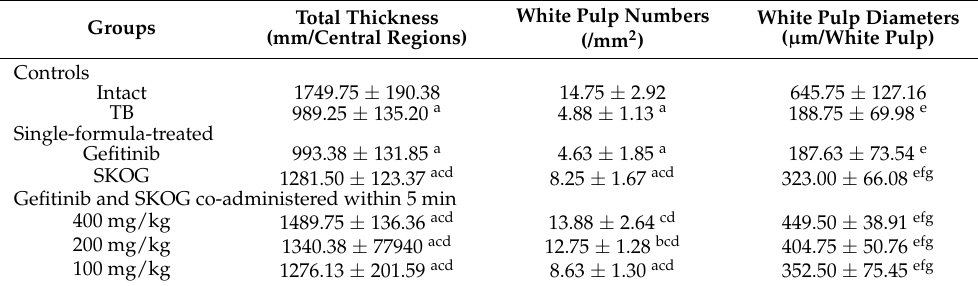
Table 7. Changes in the spleen histomorphometry of NCI-H520 tumor cell xenograft mice.